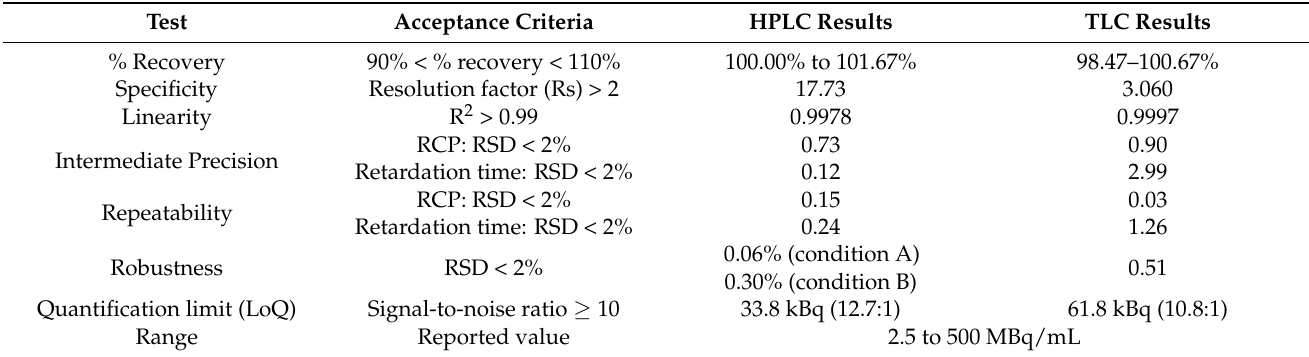
Table 7. Summary table of criteria and their